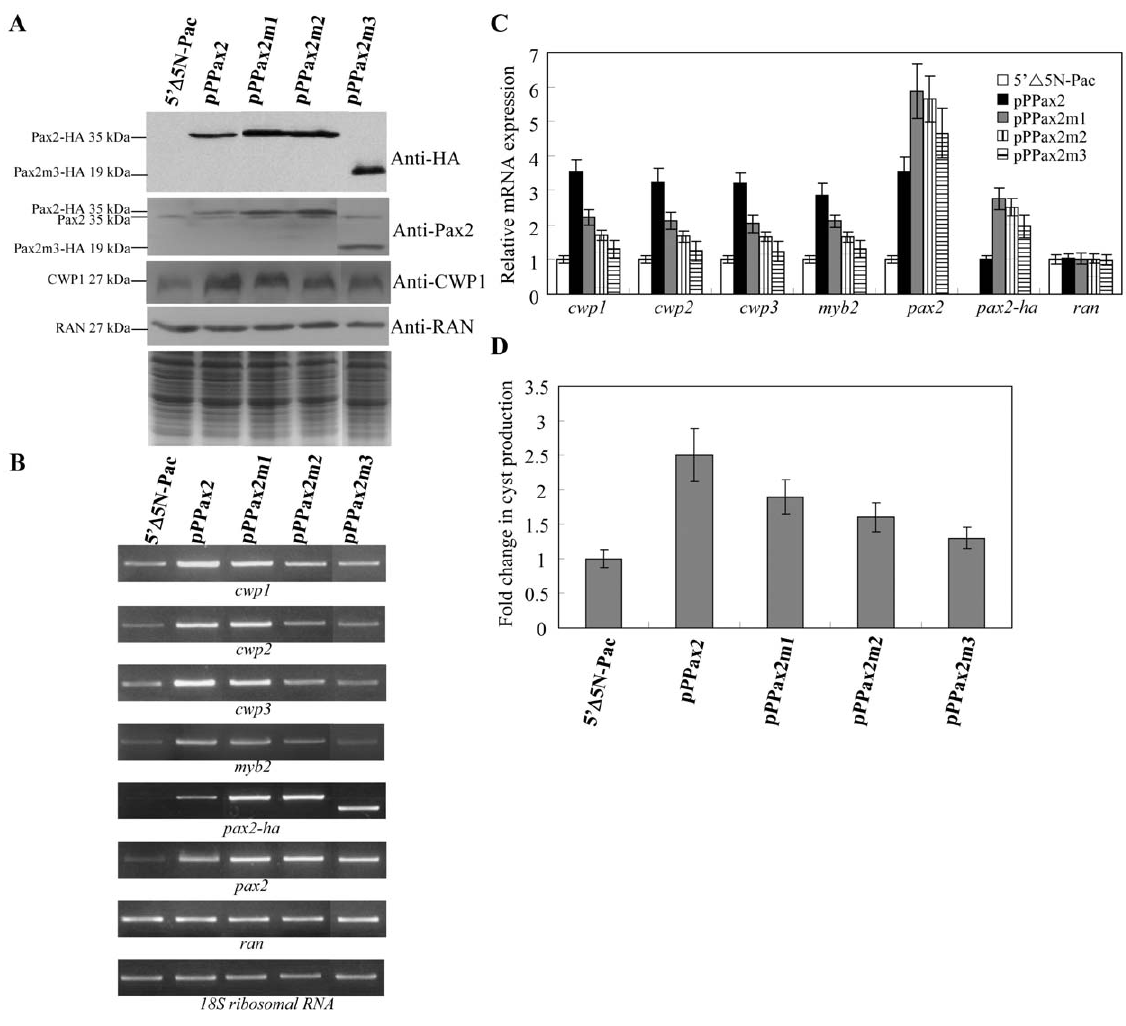
Figure 8. Activation of cwp1-3 and myb2 gene expression in the Pax2 overexpressing cell line. (A) Overexpression of Pax2 increased the levels of CWP1 protein. The 5 9 n 5N-Pac, pPPax2, and pPPax2m1-3 stable transfectants were cultured in growth medium and then subjected to SDS- PAGE and Western blot. The blot was probed by anti-Pax2, anti-HA and anti-CWP1 antibody. Equal amounts of protein loading were confirmed by SDS-PAGE and Coomassie blue staining. Representative results are shown. (B) RT-PCR analysis of gene expression in the Pax2 and Pax2m1-3 overexpressing cell lines. The 5 9 n 5N-Pac, pPPax2, and pPPax2m1-3 stable transfectants were cultured in growth medium and then subjected to RT- PCR analysis using primers specific for pax2-ha , pax2 , cwp1 , cwp2 , cwp3 , myb2 , ran , and 18S ribosomal RNA genes. (C) Quantitative real-time PCR analysis of gene expression in the Pax2 and Pax2m1-3 overexpressing cell lines. Real-time PCR was performed using primers specific for pax2-ha , pax2 , cwp1 , cwp2 , cwp3 , myb2 , ran , and 18S ribosomal RNA genes. Similar mRNA levels of the ran and 18S ribosomal RNA genes for these samples were detected. Transcript levels were normalized to 18S ribosomal RNA levels. Fold changes in mRNA expression are shown as the ratio of transcript levels in the pPPax2 or pPPax2m1-3 cell line relative to the 5 9 n 5N-Pac cell line. Results are expressed as the means 6 standard error of at least three separate experiments. (D) Cyst count. The 5 9 n 5N-Pac, pPPax2, and pPPax2m1-3 stable transfectants were cultured in growth medium and then subjected to cyst count as described under ‘‘ Methods ’’. The sum of total cysts is expressed as relative expression level over control. Values are shown as means 6 standard error.